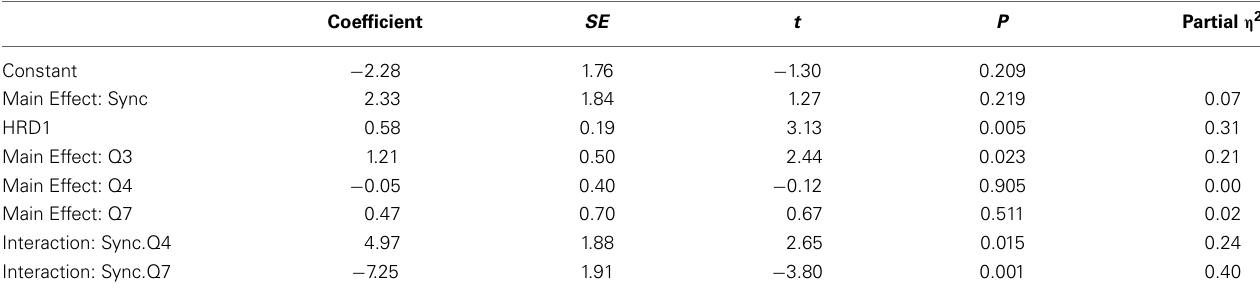
Table 4 | Regression of HRD2 on HRD1, condition (Async, Sync), Q3 (My Body), Q4 (Drifting Forwards) and Q7 (Avatar Drifting